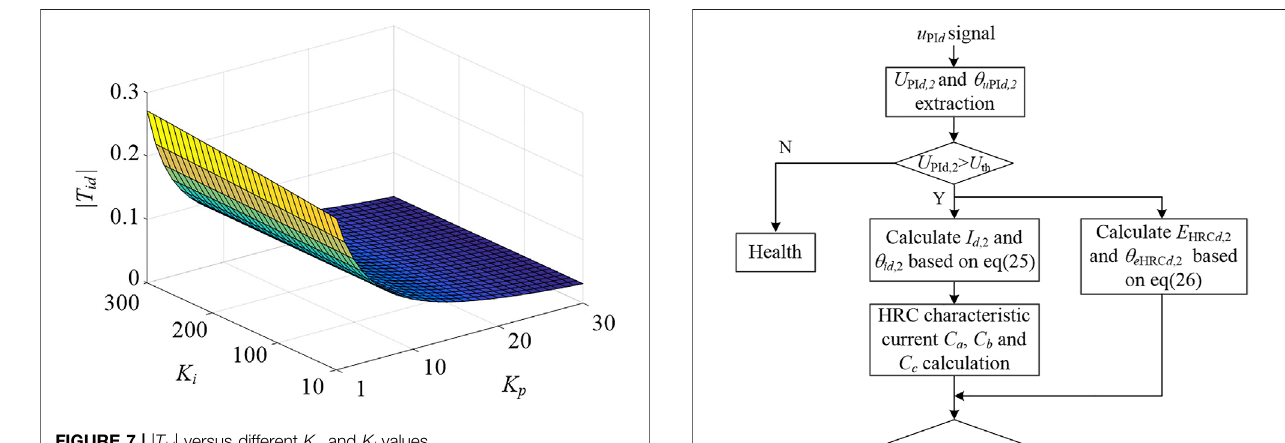
FIGURE 7 | | T id | versus different K p and K i values.